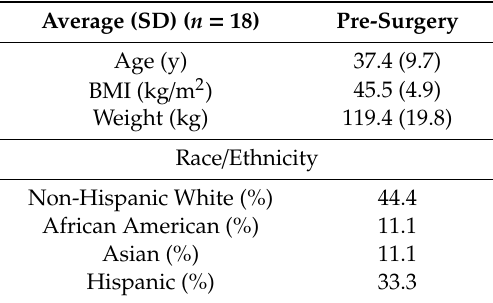
Table 1. Baseline patient characteristics.